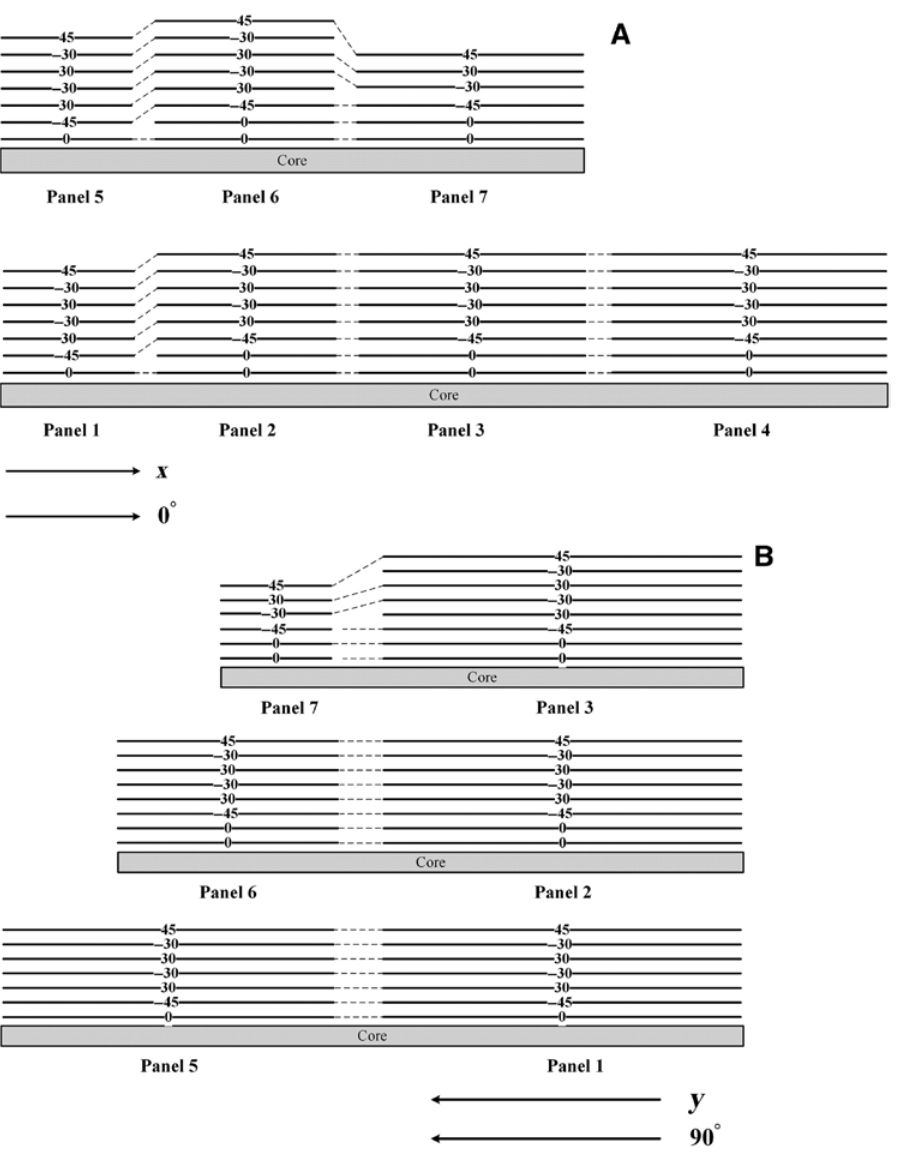
Figure 13: (A) The cross-sections of face sheets in the view from the x direction. (B) The cross-sections of face sheets in the view from the y direction. The optimization results for the seven-sandwich-panel structure with identical core thicknesses.